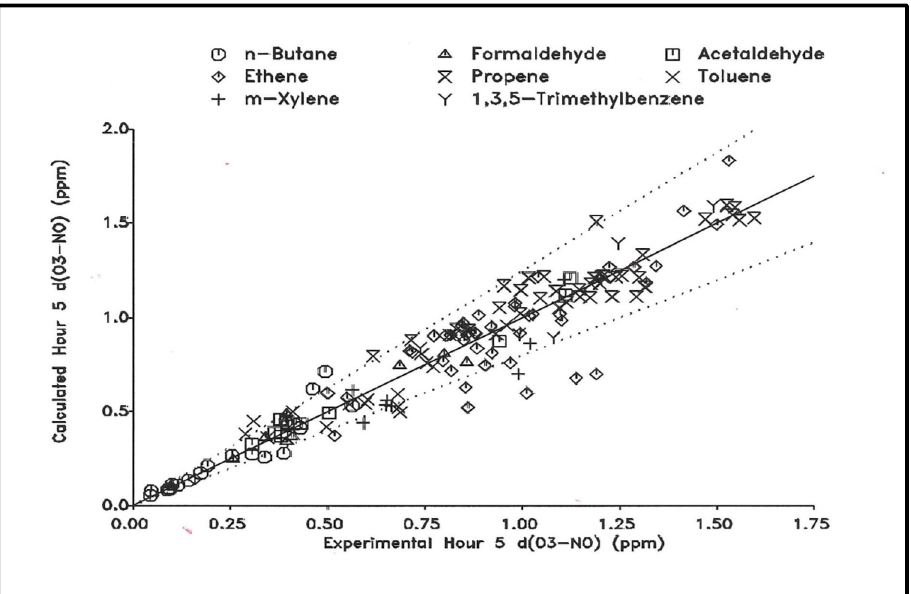
Figure 5. Experimental vs. calculated O 3 formed plus NO oxidized for selected single compound-NO x experiments. Calculations were made using a version of the SAPRC-90 mechanism [178].